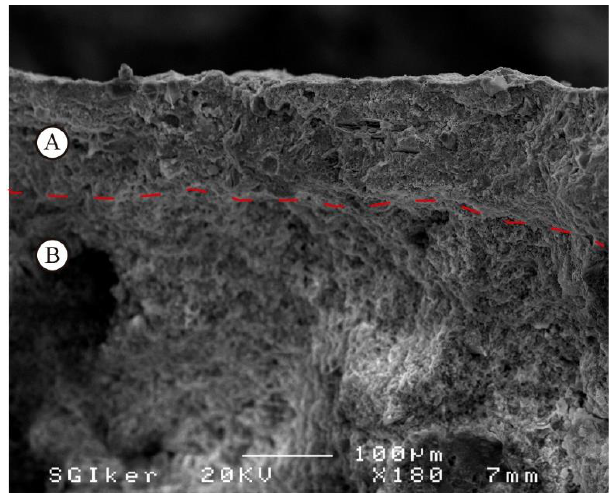
Figure 7. SEM image of the cistern plaster. A: pigmented layer; B: inner layer. Rough contact surface in red.